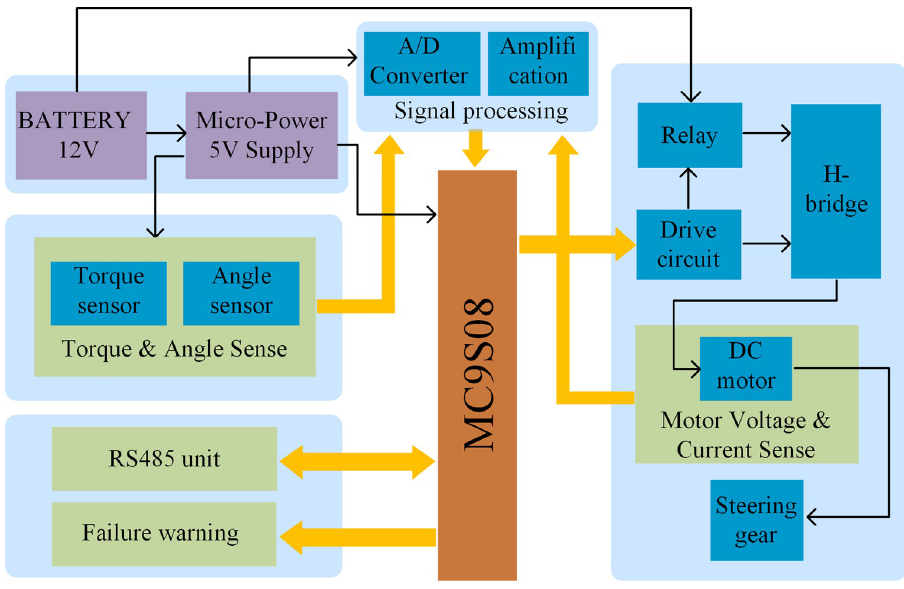
Fig 5. Block diagram of the control